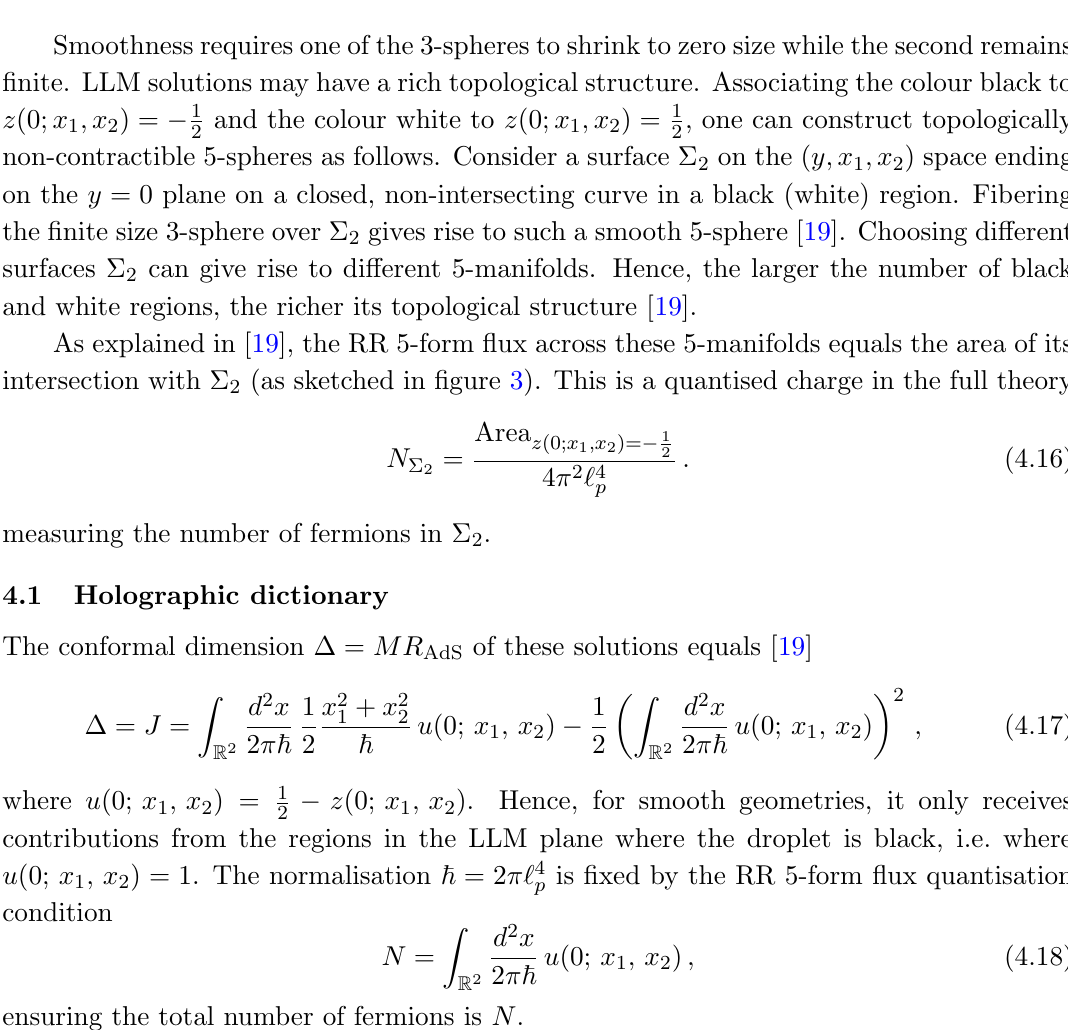
Figure 3 . 2-dimensional surface (cid:6) where to evaluate the number of fermions in phase space insight (cid:6) by computing the (cid:13)ux of the RR 5-form over a 5-dimensional surface including a (cid:12)nite size